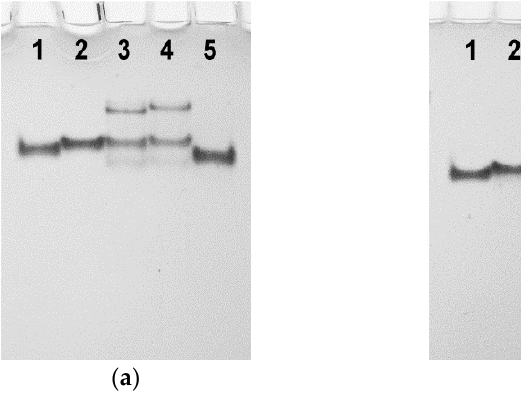
Figure 5. ( a , b ) Native polyacrylamide gel electrophoresis of the modified variants TBA2α, 3Q4α, 3Q, and 3Q-ppg at 20 °C in the presence of 10 mM KCl ( a ) or 10 mM NaCl ( b ). (1) TBA-ppg, (2) TBA2α, (3) 3Q, (4) 3Q-ppg, and (5) 3Q4α. ( c ) Native gel-electrophoresis image of the labeled aptamers TBA2α-Cy5, 3Q4α-Cy5, and 3Q-ppg-Cy5 alone and in the presence of 2.4 equivalent thrombin (12% polyacrylamide gel, 20 °C, 10 mM KCl). (1) TBA-ppg-Cy5, (2) TBA2α-Cy5, (3) 3Q4α-Cy5, and (4) 3Q-ppg-Cy5. Symbol (+) indicates added thrombin.